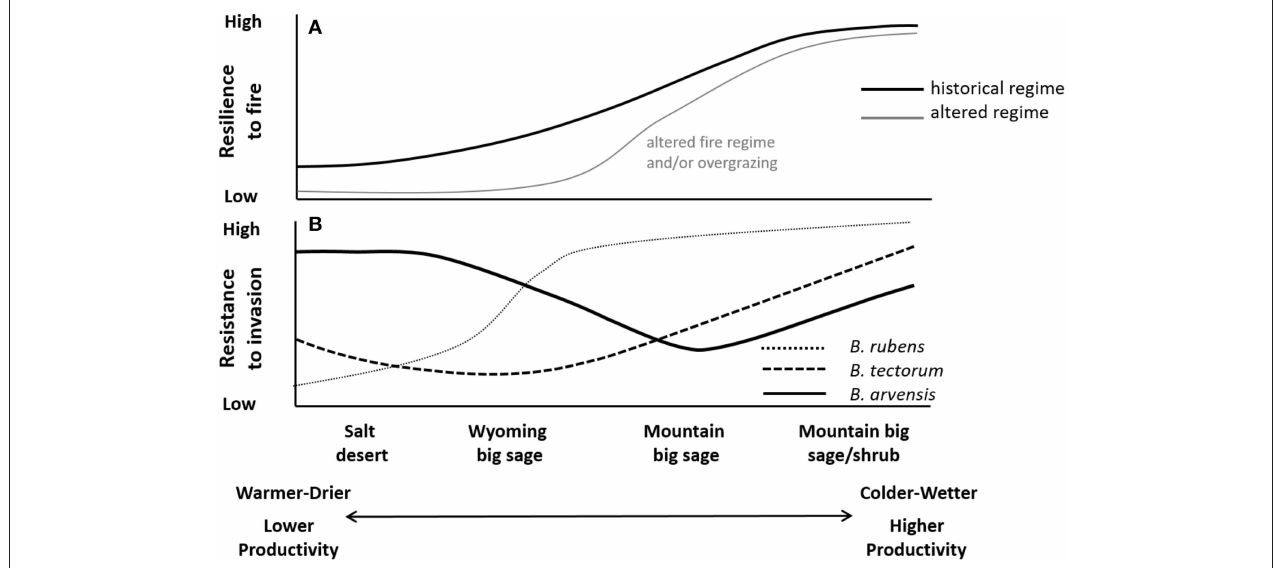
FIGURE 7 | Hypothetical (A) resilience to historical and altered disturbance regimes (primary altered regime characteristic labeled in gray) and (B) resistance to common invasive annual grass species in the Cold Deserts. Adapted from Chambers et al.